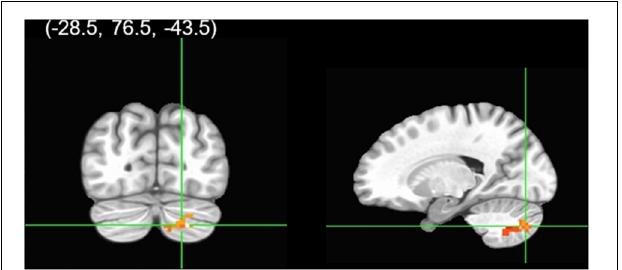
FIGURE 2 | Group analysis of connectivity with the right rACC during correct calm No-go trials. A gender group contrast revealed the right rACC had greater functional connectivity with a cluster in the right cerebellum in males relative to females. The colors represent areas of significant connectivity; warm colors indicate increased connectivity (voxelwise threshold p < 0.005; family-wise correction p <